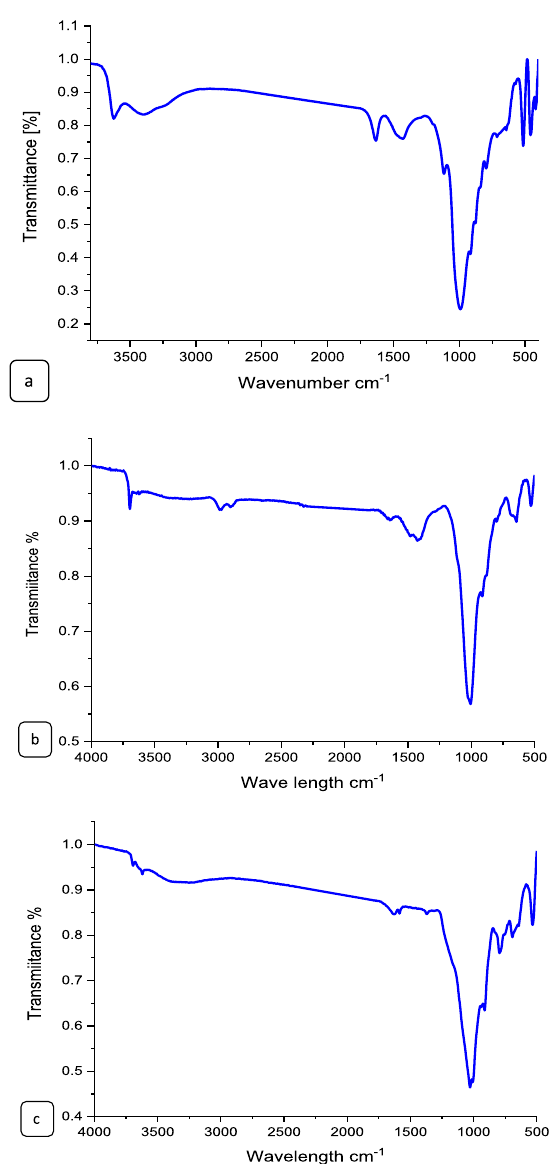
Fig. 4 FTIR images of a raw bentonite, b nano-bentonite and c MgO impregnated into